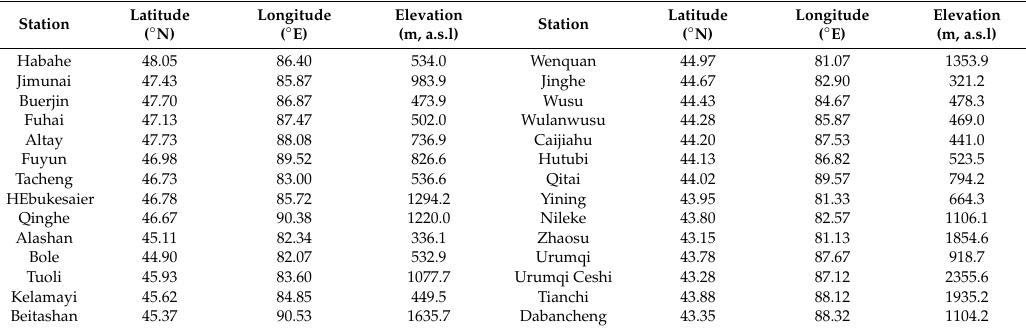
Figure 1. Specific position of Northern Xinjiang within the Eurasian Continent. The topography (m), major rivers, and 28 meteorological stations in Northern Xinjiang are shown. Table 1. Information of the 28 meteorological stations in Northern Xinjiang, including the name, latitude, longitude and elevation.